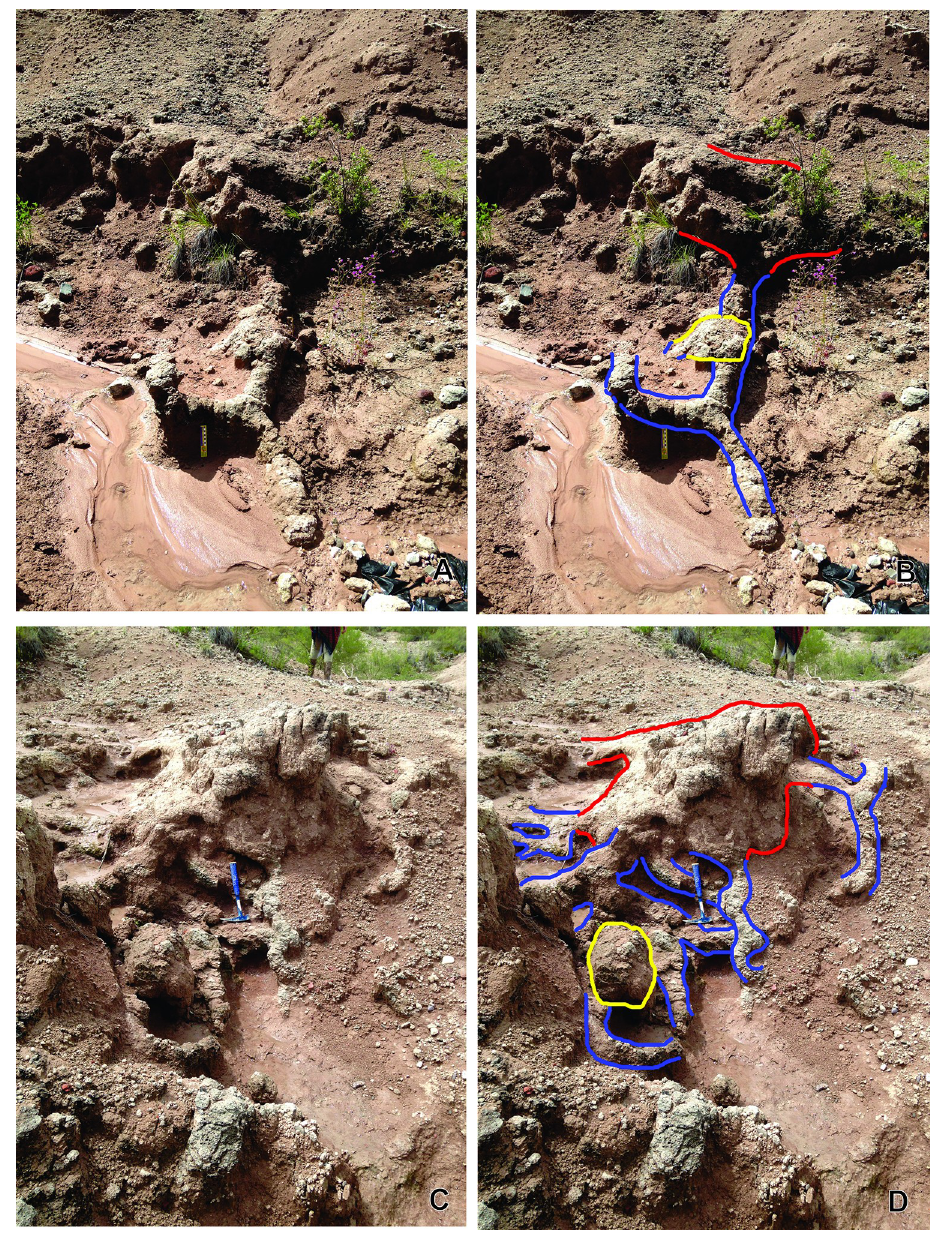
Fig 4. Yaviichnus iniyooensis morphology. (A, C) Systems composed by a main chamber (red delineated in B, D), secondary chamber (yellow delineated in B, D) and tunnels (blue delineated in B, D). (A, C) Burrow systems are in situ , in “middle beds”